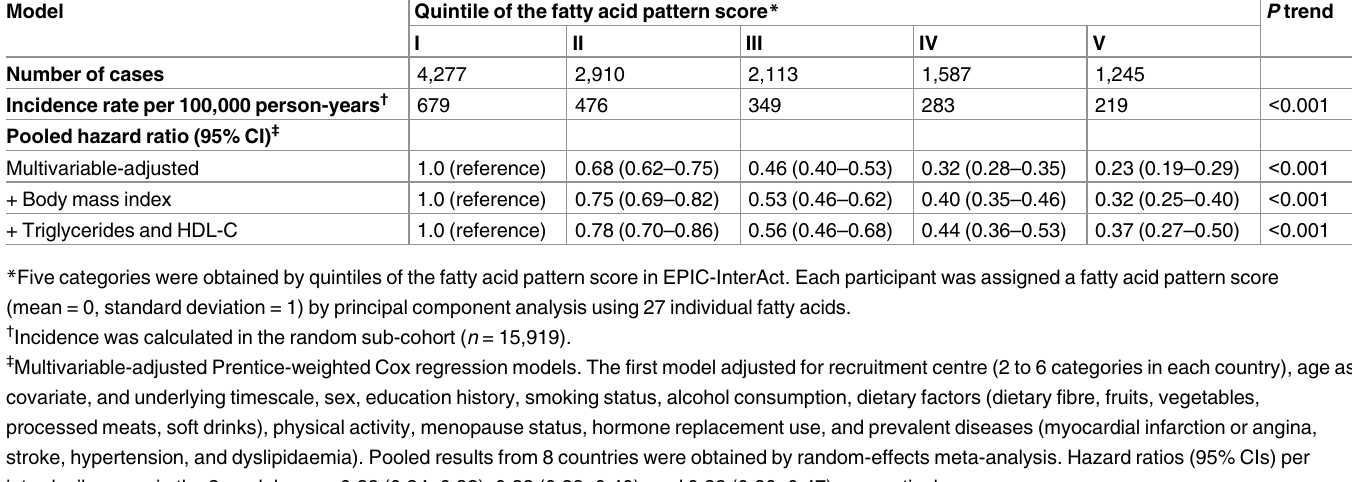
Table 2. Association of the fatty acid pattern score with incidence of type 2 diabetes: EPIC -InterAct ( n = 27,296).